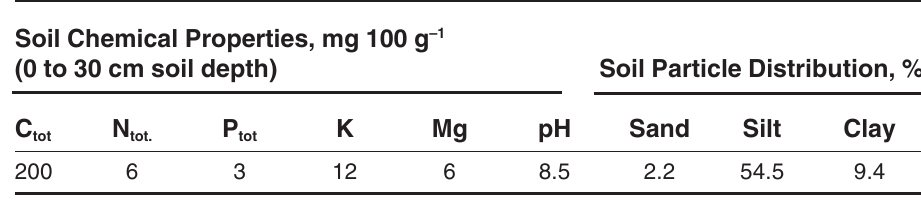
The Soil Chemical and Physical